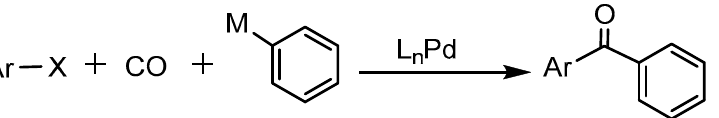
Scheme 1. Transition metal-catalyzed carbonylative cross-coupling reactions to ketones.